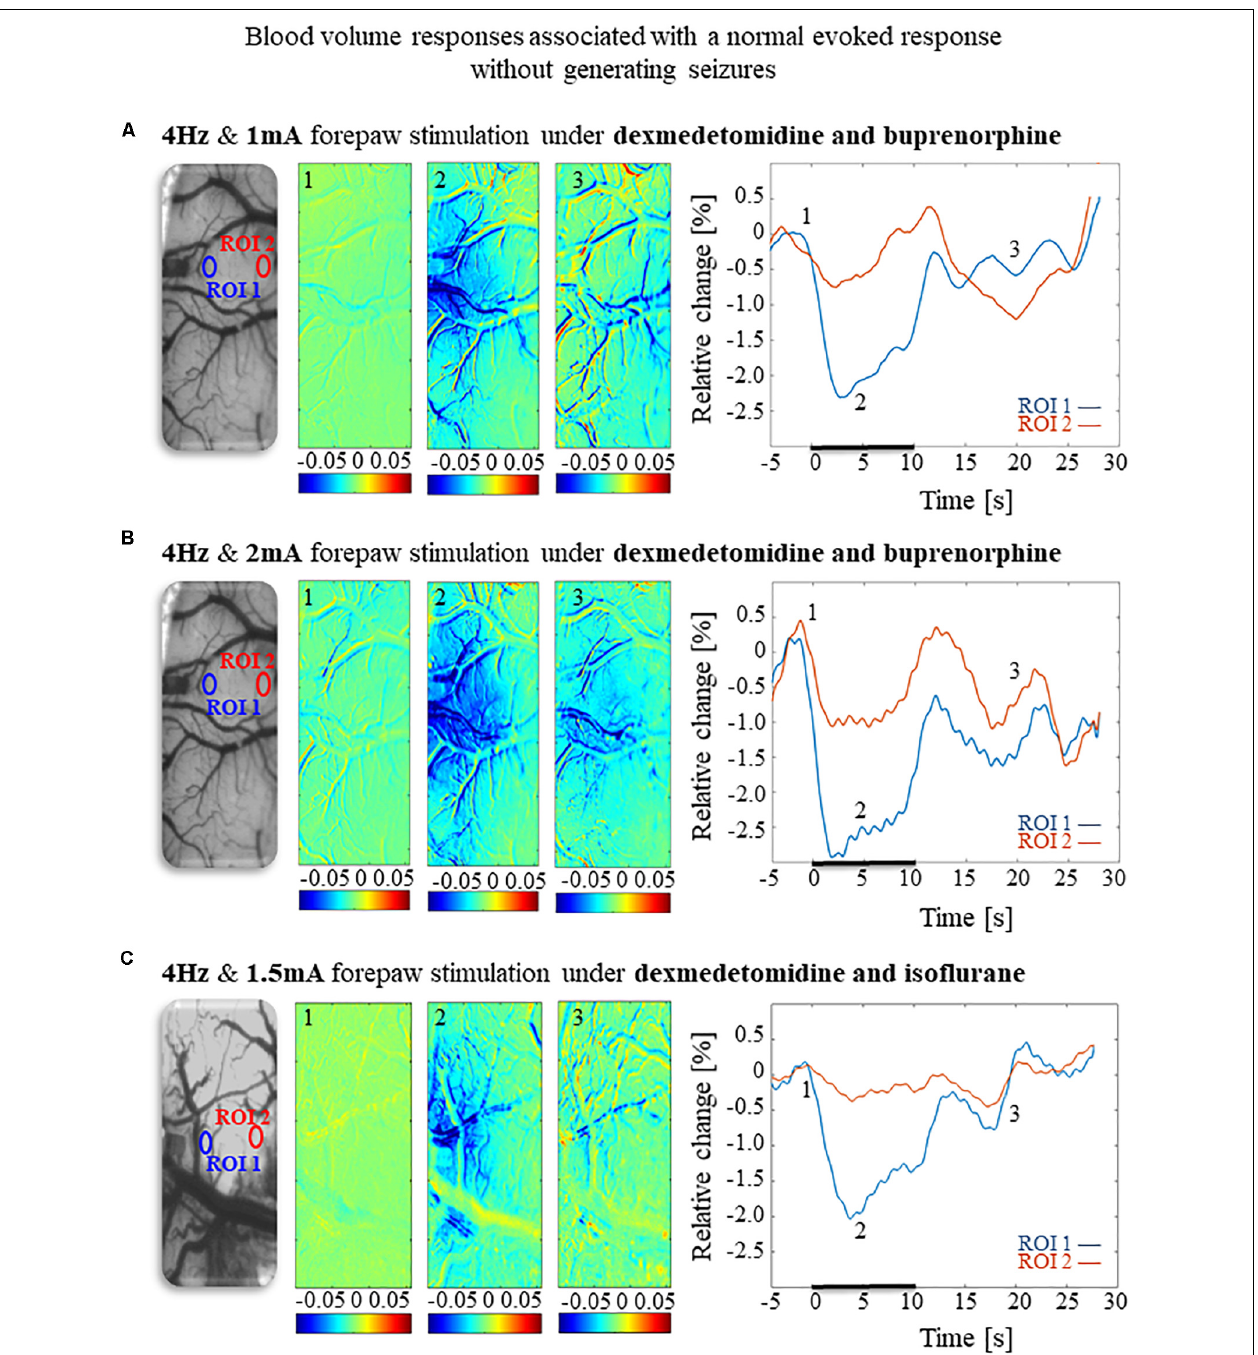
FIGURE 9 | Cerebral blood volume responses associated with seizure-free responses to 4 Hz forepaw stimulation under different anesthesia regimes. (A) A cerebral blood volume response to a 10 s-long block of forepaw stimuli of 1 mA administered at 4 Hz under dexmedetomidine and buprenorphine sedation. To the left, the imaged cortical surface. The 3 maps presented in color show the spatial responses before (the 1 s before stimulus onset), during (4–5 s following stimulus onset), and after (9–10 s following the cessation of the stimulus) the 10 s-long forepaw stimulation period. The reference for obtaining these responses was imaged between 3 and 1 seconds before stimulus onset. Note that negative responses indicated in indexed blue colors represent increases in blood volume. To the right are two time-courses presenting the corresponding temporal responses from two regions (blue and red ROIs in the left panel) within the activated area. The stimulation period between 0 and 10 seconds is marked by a dark bar. (B) Cerebral blood volume response evoked by 4 Hz and 2 mA forepaw stimulation under dexmedetomidine and buprenorphine sedation. The format of the presentation is identical to that used in panel A. (C) Cerebral blood volume response evoked by 4 Hz and 1.5 A forepaw stimulation under dexmedetomidine and isoflurane anesthesia. The format of the presentation is identical to that used in panel A.